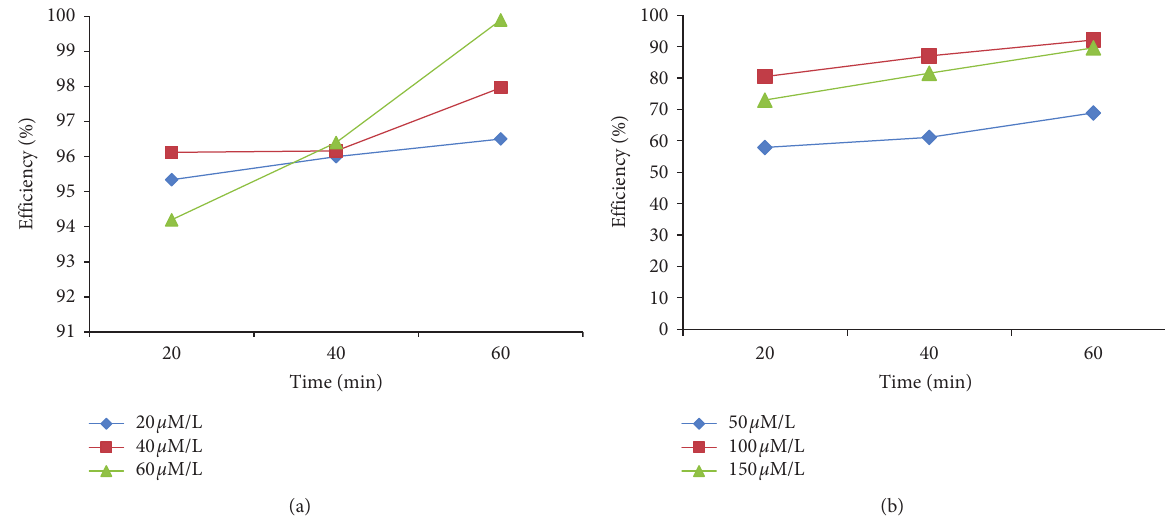
Figure 3: Trifluralin removal efficiency: (a) different persulfate concentrations (initial trifluralin concentration � 1.2mg/L, pH � 9, UV � 6 W) and (b) different ZnO concentrations (initial trifluralin concentration � 0.6mg/L, pH � 9, UV �